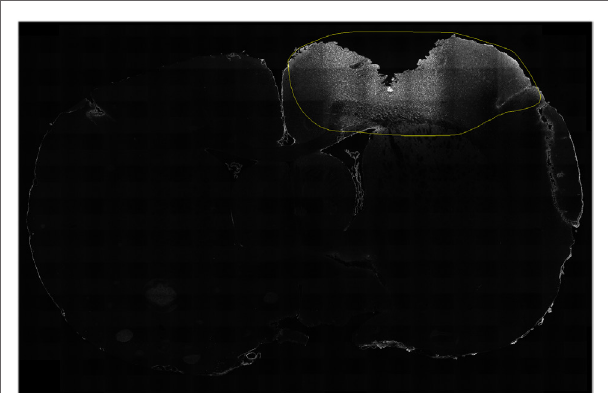
FigUre 2 | Detection of expression . A person blinded for oxygenation state and survival time highlighted the region of interest surrounding the lesion (yellow circle). The protein expression, above a specific threshold, was then used to quantify the expression. In this case, the expression of C5b-9 (white) is shown in a hypoxic animal, at 1 day following